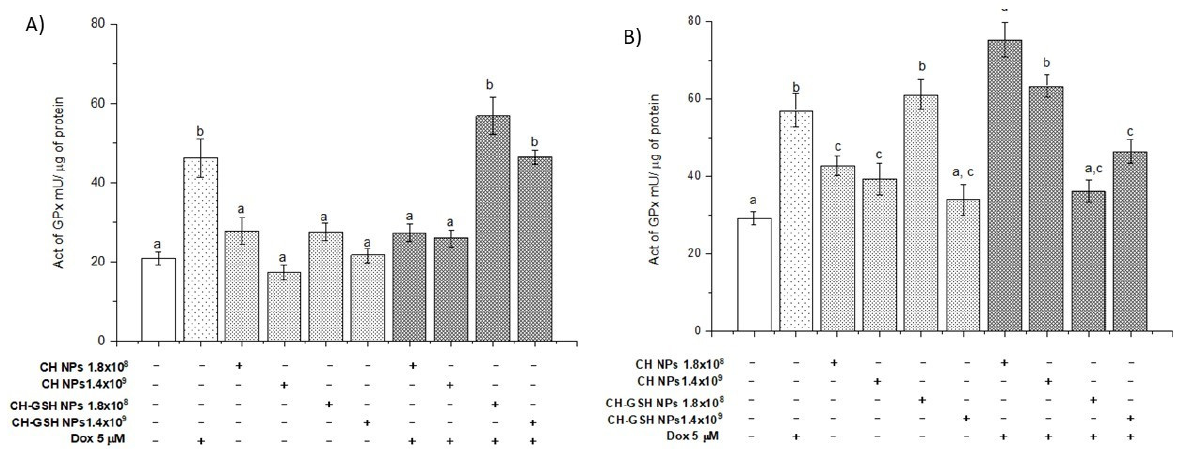
Figure 8. The activity of GPx. The cells were exposed to Dox for 12 h and then 2 h with CH-GSH NPs or CH-NPs. ( A ) MCF-7 and ( B ) MDA MB-231 cells. Bars with equal letters indicate significant differences between the means (Tukey’s test, p <0.05).